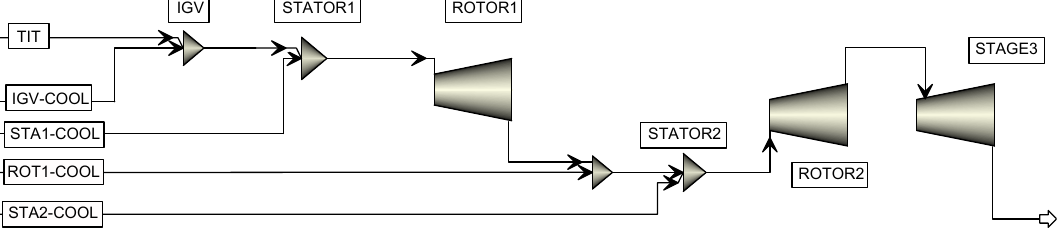
Figure 6. Aspen plus flow sheet of the applied turbine model and the case with IGVs (see Section